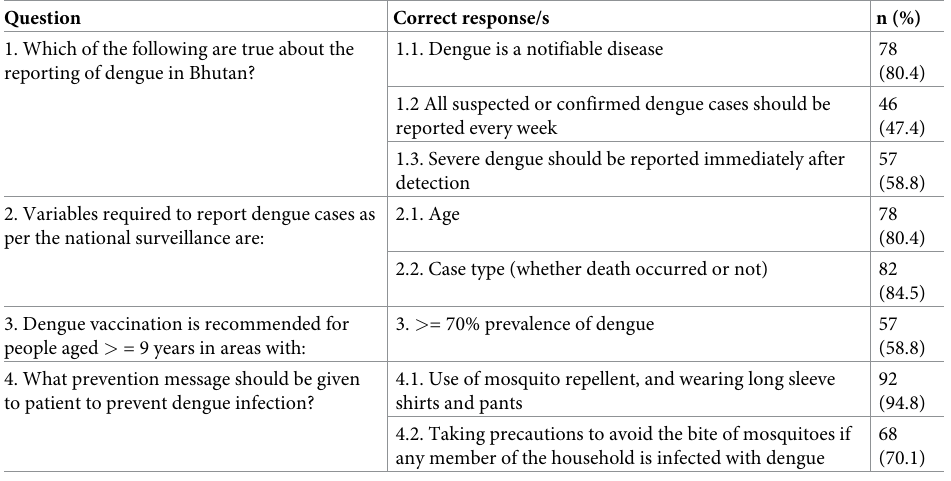
Table 5. Surveillance reporting and prevention of dengue (domain 4), Bhutan,